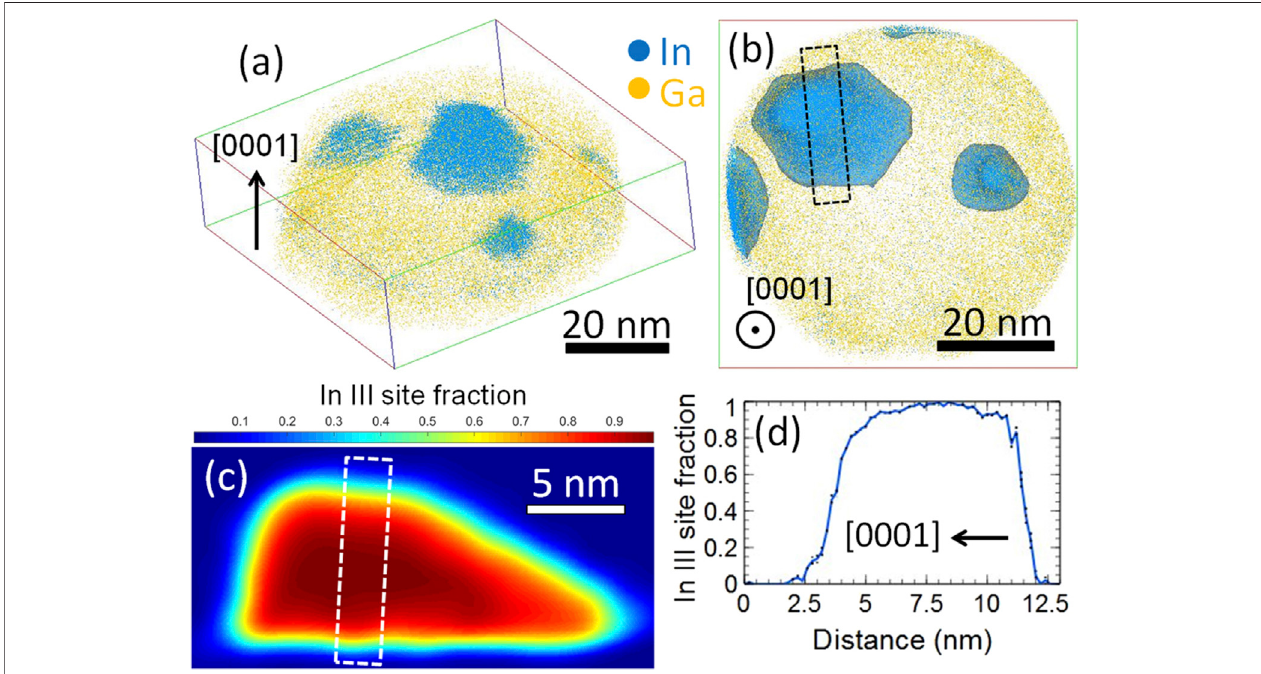
FIGURE 1| Atom probe tomography data ofInN QDs on GaN grown by MOCVD. (A) 3D reconstruction, (B) top view with a50% In iso-concentration surface, (C) 2Dsideviewextractedfromdashedregionin (B) ,and (D) 1Dconcentrationpro fi leofInextractedfromdashedregionin (C) .Detectionratewas0.005atomspulse − 1 and detectionef fi ciencywas37%,withmoreinformationinthereferences.FromBonefetal.,Appl.Phys.Express13,065005(2020).Copyright(2020)TheJapanSocietyof Applied Physics (Bonef et al., 2020; Bonef et al., 2017).